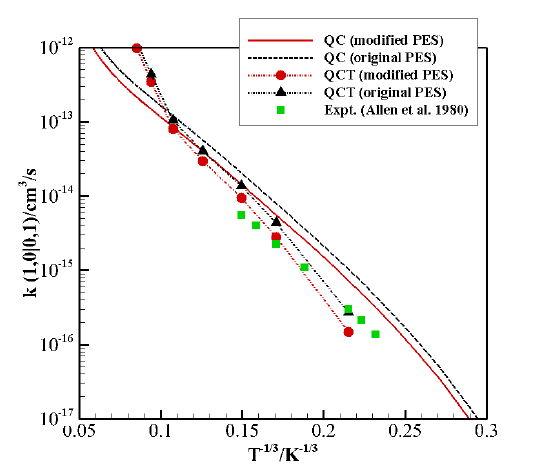
Figure 3. Landau–Teller plot of rate coefficients for the transition (1,0) → (0,1) calculated by the QC method on the original PES (dash black line) and on the modified PES (full red line), and by the QCT method on the original PES (dash-dot black line with triangle symbols) and on the modified PES (dash-dot red line with circle symbols). Experimental data of ref. [41] (green squares) are also